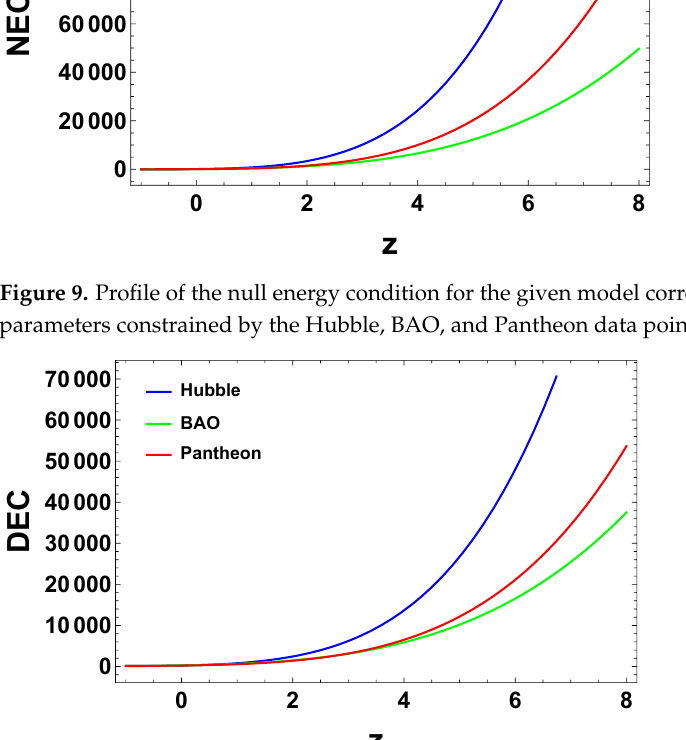
Figure 10. Profile of the dominant energy condition for the given model corresponding to the values of the parameters constrained by the Hubble, BAO, and Pantheon data point sets.